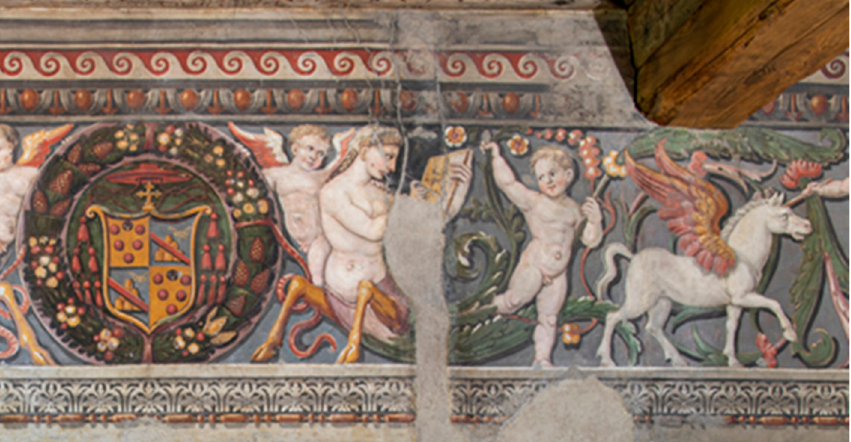
Figure 3. Detail of the frieze decoration on the south wall after restoration, original painting.